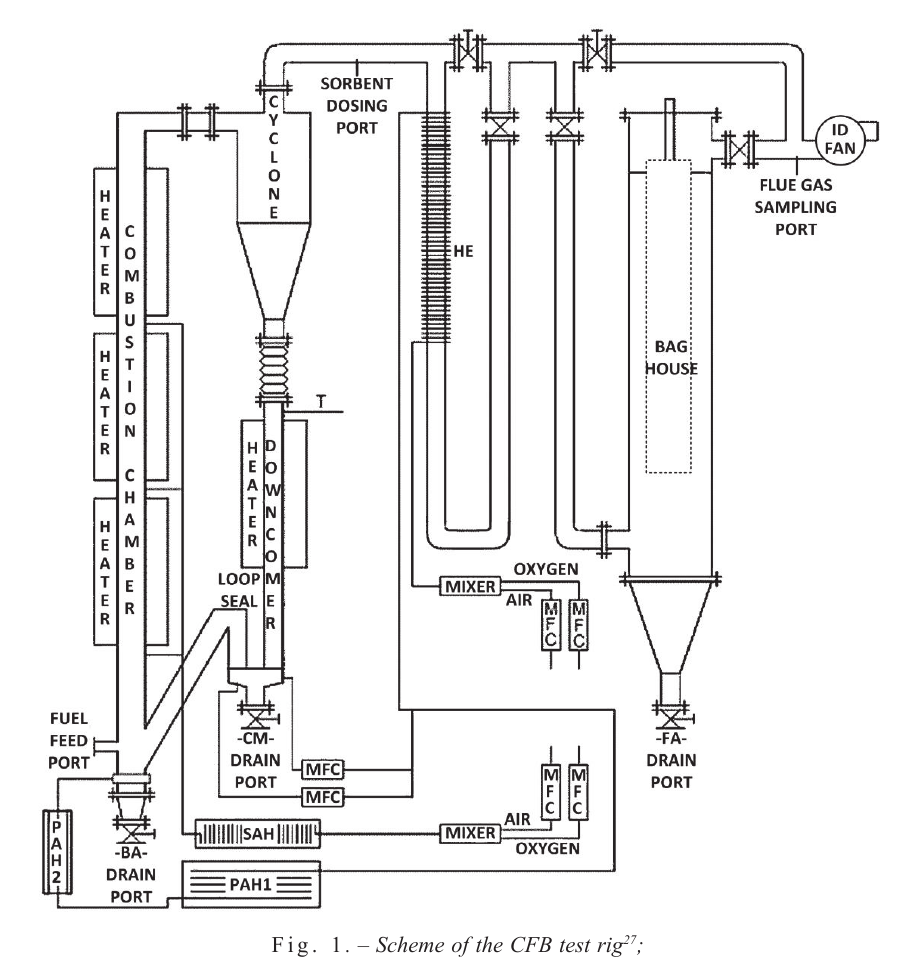
Fig. 1 . – Scheme of the CFB test rig 27 ; Fig. 1 Scheme of the CFB test rig